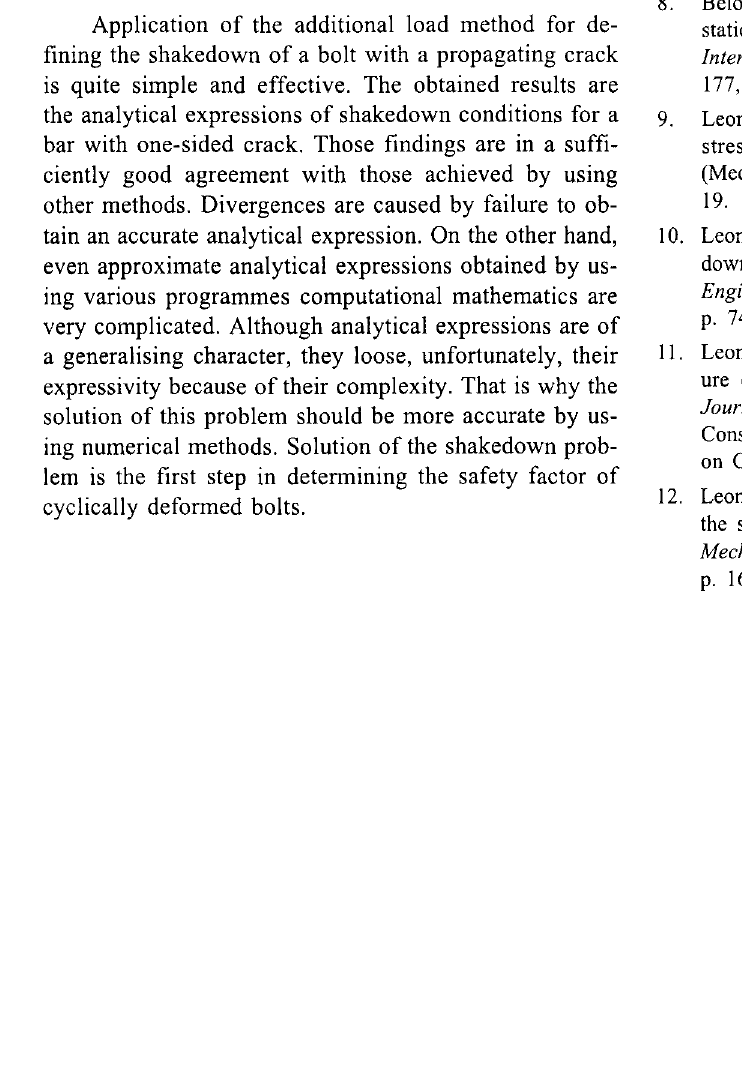
Fig 2. Dependence of the cracked bolt shakedown zone on the crack depth Depending on the crack depth, the bolt shakedown zone may be drawn in the area of stresses (Fig 2). Straight lines 2 define the zone that limits progressing plastic frac ture, and the zone of alternating plastic deformation is described by straight lines